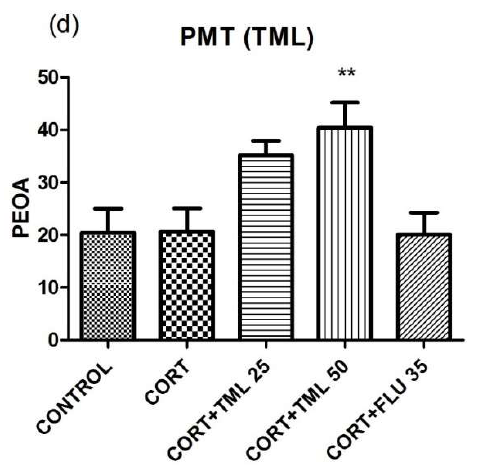
Figure 8. Effects of repeated administration of LSEO (100 and 200 mg/kg; p.o.) in the NEOA ( a ) and PEOA ( c ) and TML (25 and 50 mg/kg; p.o.) in the NEOA ( b ) and PEOA ( d ) on animals treated with CORT (22 days, 20 mg/kg, s.c.) in the plus maze test. Values are expressed as the mean ± SEM ( n = 10). Significant values: * p <0.05, ** p <0.001, *** p < 0.0001 vs. CORT. LSEO = Lippia sidoides essential